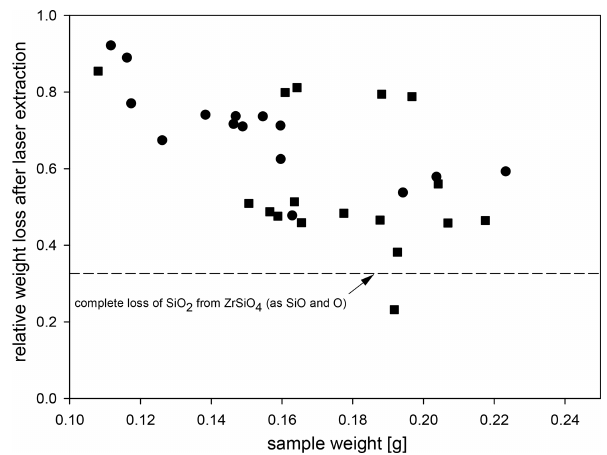
Figure 6. Relative mass loss of zircon samples after laser extrac- tion as a function of initial sample weight. Squares denote samples with grain sizes above 125µm; circles denote samples that (also) contain grains smaller 125µm. All but one sample (RBM-6) have completely lost their constituent SiO 2 and some of the ZrO 2 residue (see also Fig.